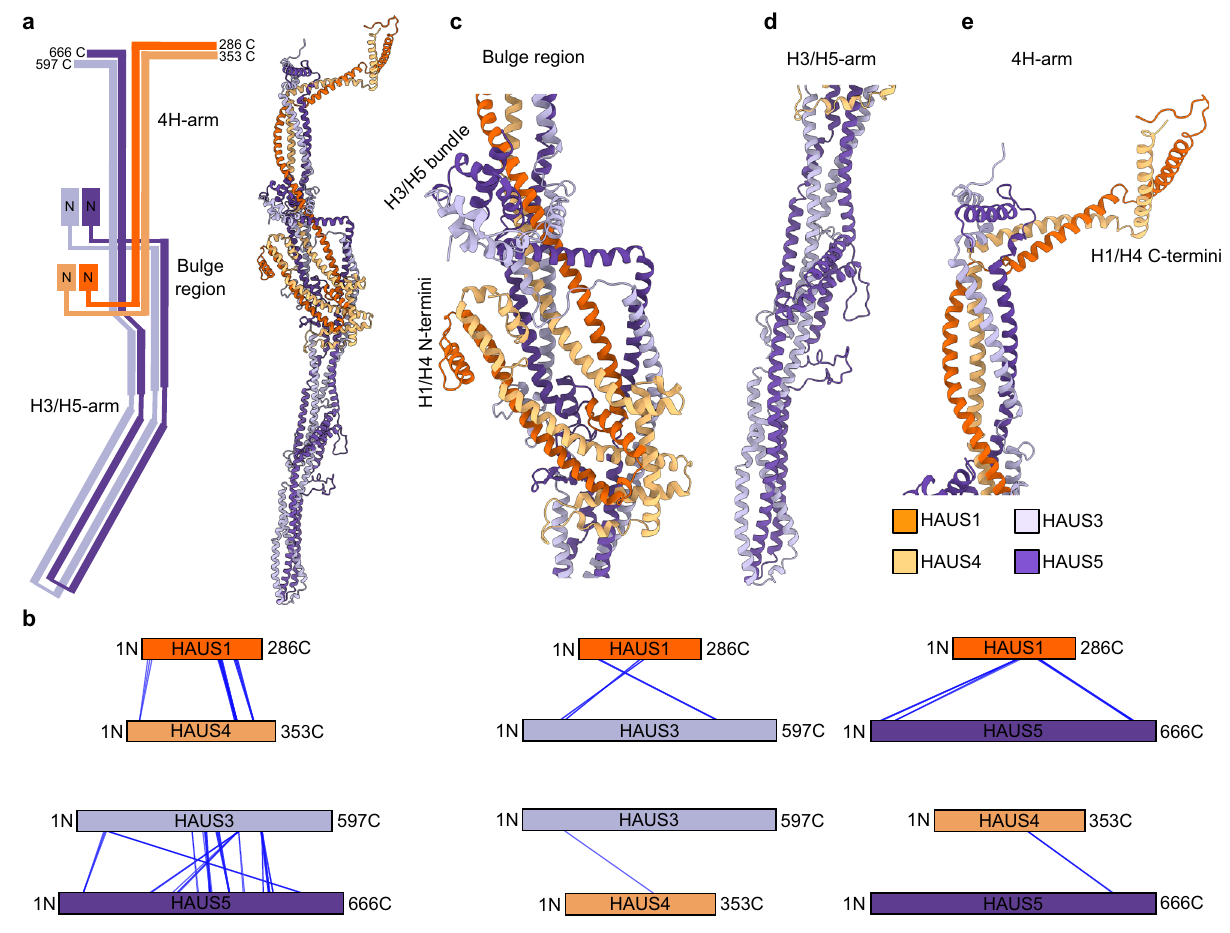
Fig.3|StructureoftheaugminTIIItetramer.a Left:schematicrepresentationof thesubunitorganisationoftheaugminTIIItetramer.4H-arm,bulgeregion,H3/H5- arm and the N- and C-termini of HAUS proteins are indicated. Right: model of the augmin TIII tetramer after MDFF. b Bar plot representation of crosslinks from